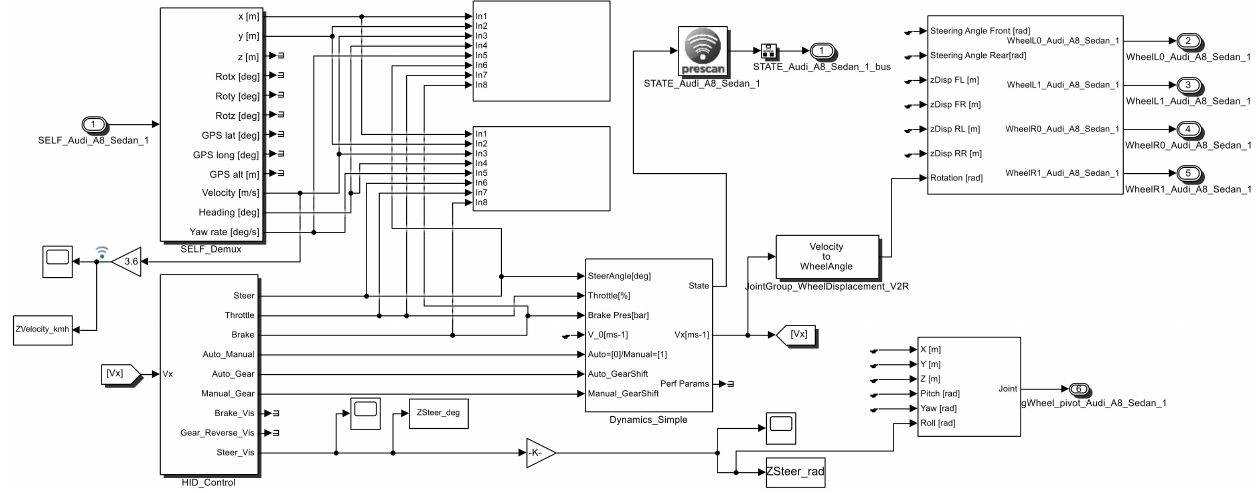
Figure 1. Prescan and Matlab joint simulation